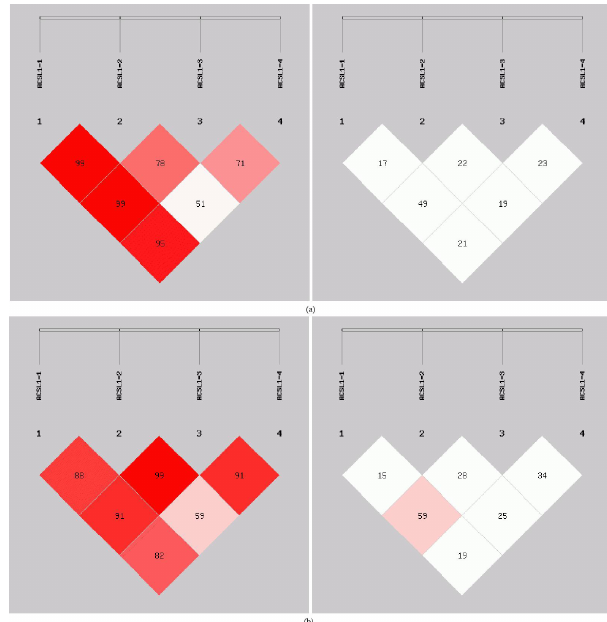
Figure 5. Linkage disequilibrium detection between ACSL1 muta- tion sites in Dezhou donkeys. (a) Linkage disequilibrium analysis of female donkeys; (b) linkage disequilibrium analysis of male don-